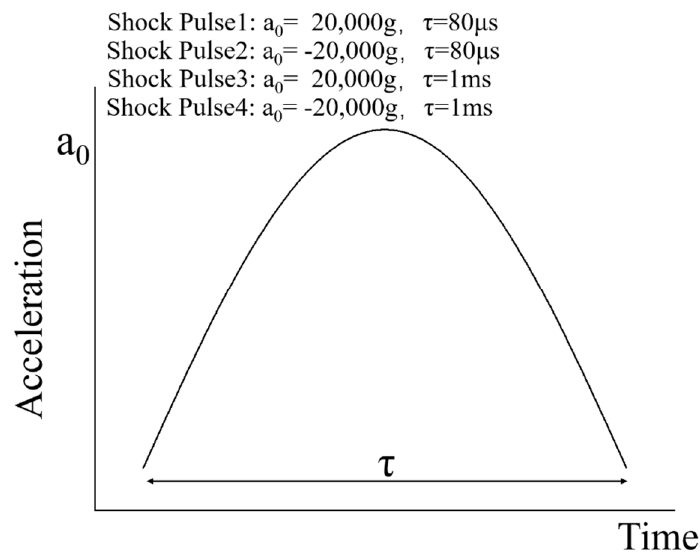
Figure 6. The Z-axis shock pulses of four different durations and directions applied in the simulation.